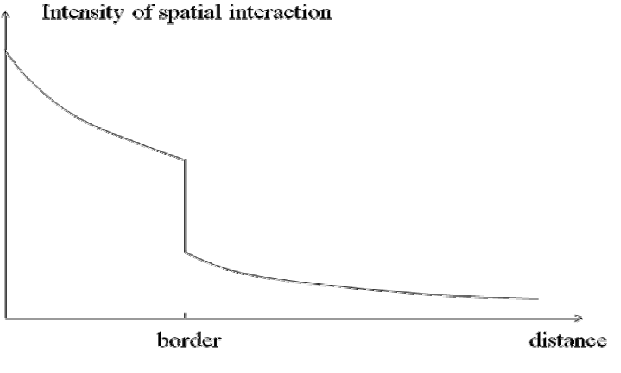
Figure 1. Discontinous effect of border on spatial interaction